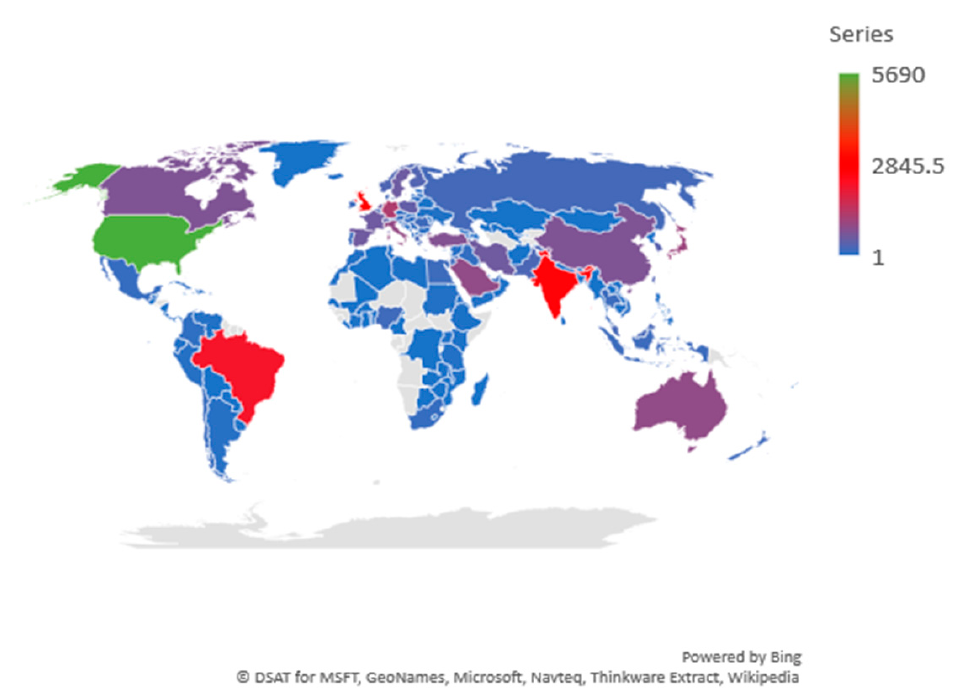
11 Figure 5. Distribution of articles by subject area. A total of 159 countries/territories sourced the articles on dentists, with the top ten